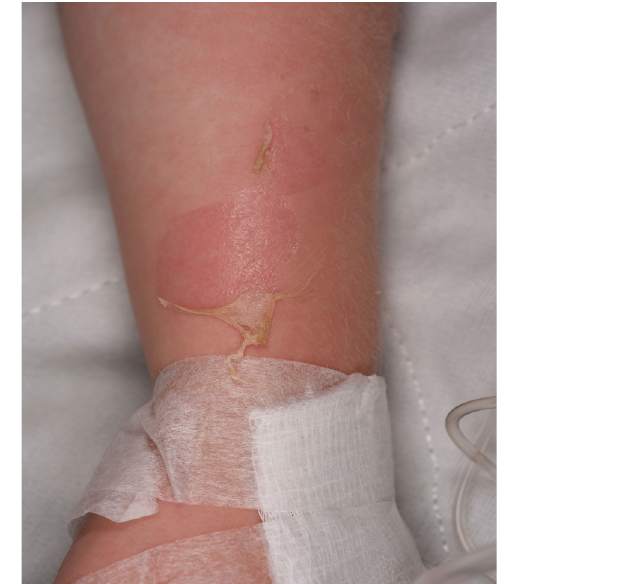
Image 2. Detail of the left forearm showing desquamation from removal of adhesive